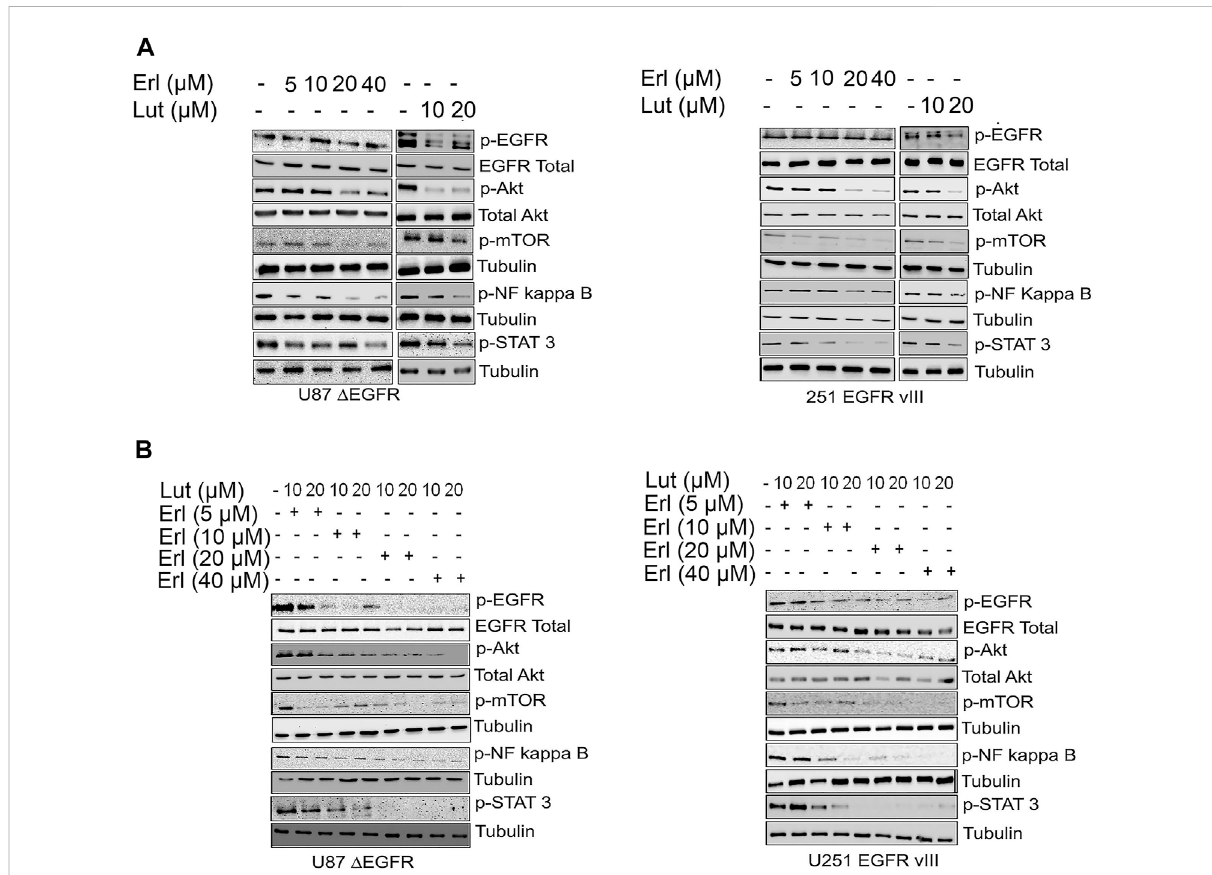
FIGURE 4 Effects of erlotinib and luteolin on growth mediated signaling proteins. (A) . The effects of increasing concentrations of erlotinib, luteolin (10 – 20 µM) alone and in combination on the expression pro fi le of phospho EGFR, Akt, NF kappa B, and Stat3 in U87 Δ EGFR and U251 EGFR vIII. (B) . The combinedeffects ofincreasingconcentrationsof erlotinib andluteolin (10 – 20 µM)on theexpression pro fi le ofphospho EGFR, Akt,NF kappa B, and Stat3 in U251 EGFR vIII.